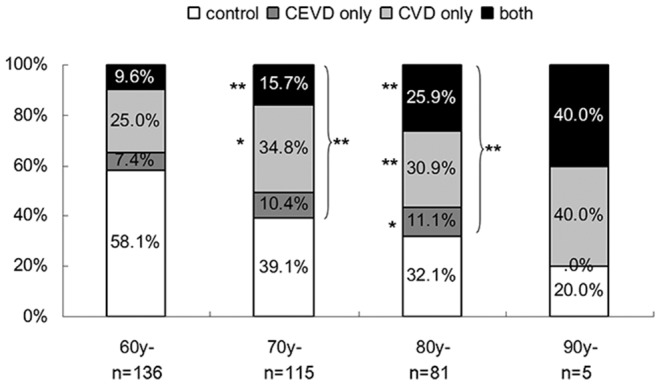
Age distribution of vascular diseases.The age range of the 60-year-old group was 60–69 years, of the 70-year-old age group was 70–79 years, of the 80-year-old group was 80–89 years and of the 90-year-old group was 90–91 years. The morbidity of CEVD, CAVD, TVD and EVD are shown as a percentage of each age group. * P<0.05, ** P<0.01 versus the morbidity of vascular diseases in the 60-year-old group.